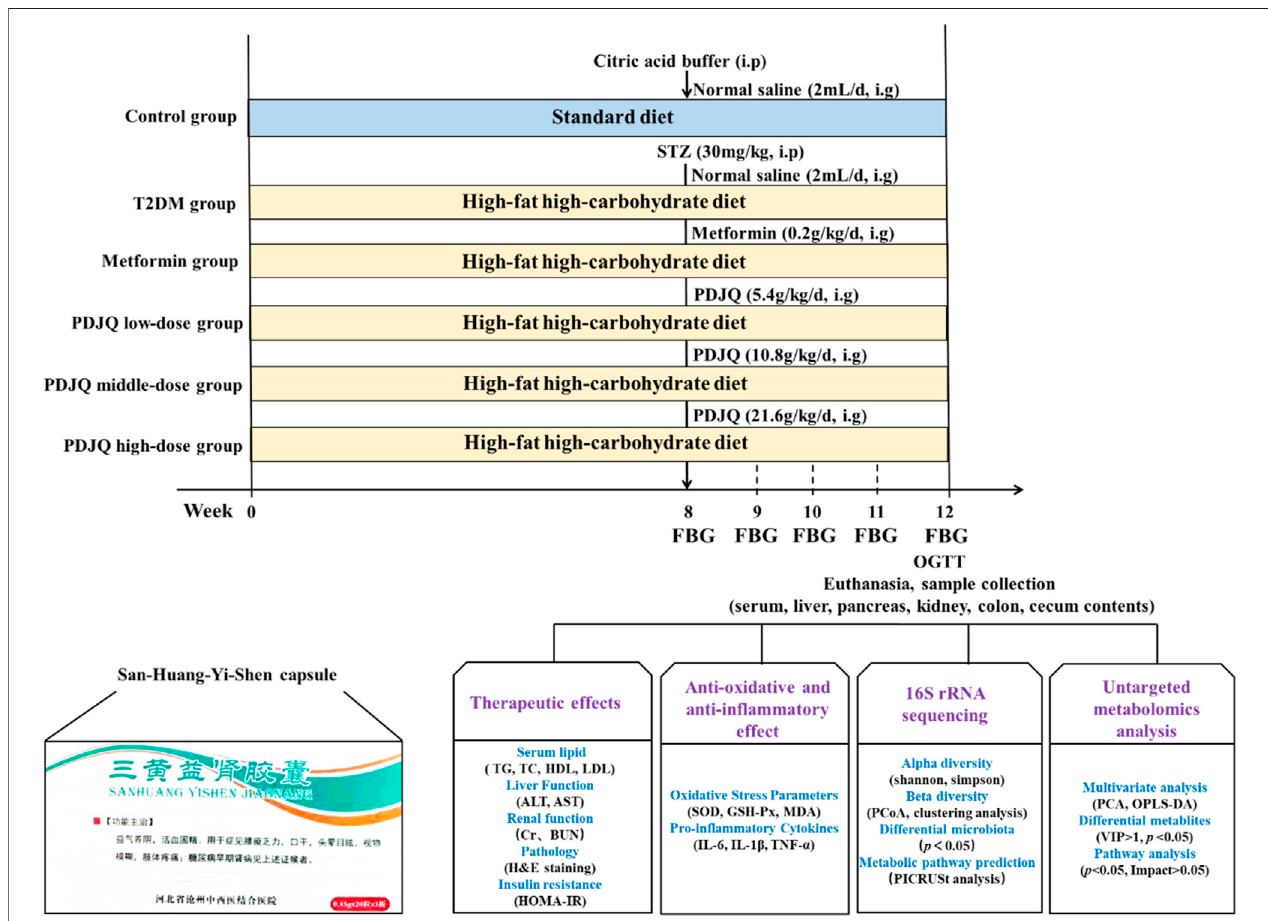
FIGURE 1 | Overview of the experimental design for all